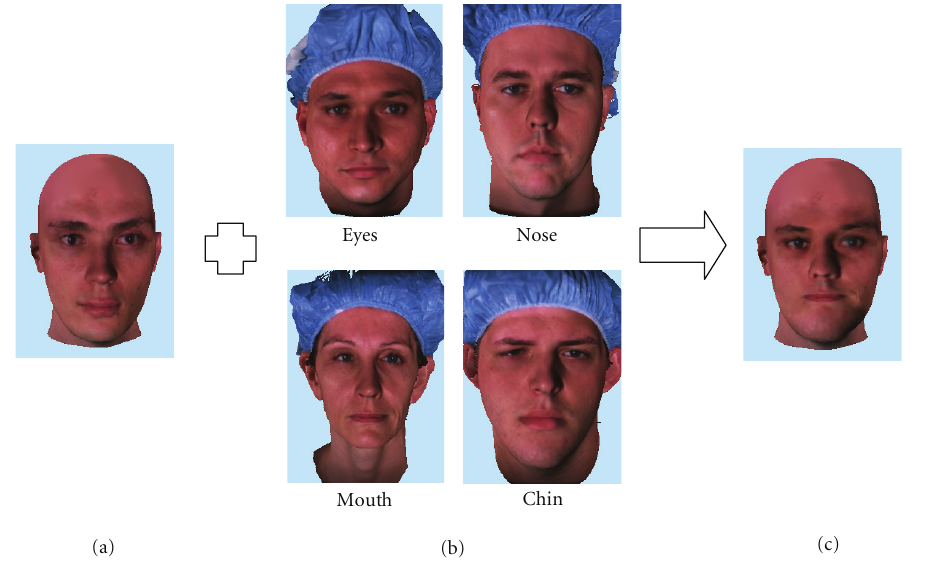
Figure 16: Facial features of four example faces (b) in our database are transferred to the source model (a) to generate a novel composite face (c).